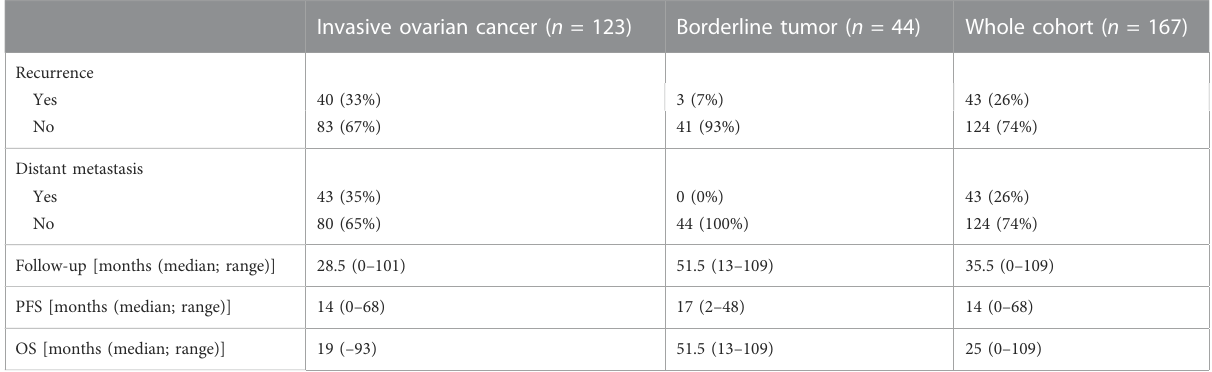
TABLE 3Oncologic outcomes for patientswith invasive ovarian cancer, borderline tumorsof the ovary and the whole cohort (PFS=progression-free survival, OS = overall survival, n = 167). Invasive ovarian cancer ( n =